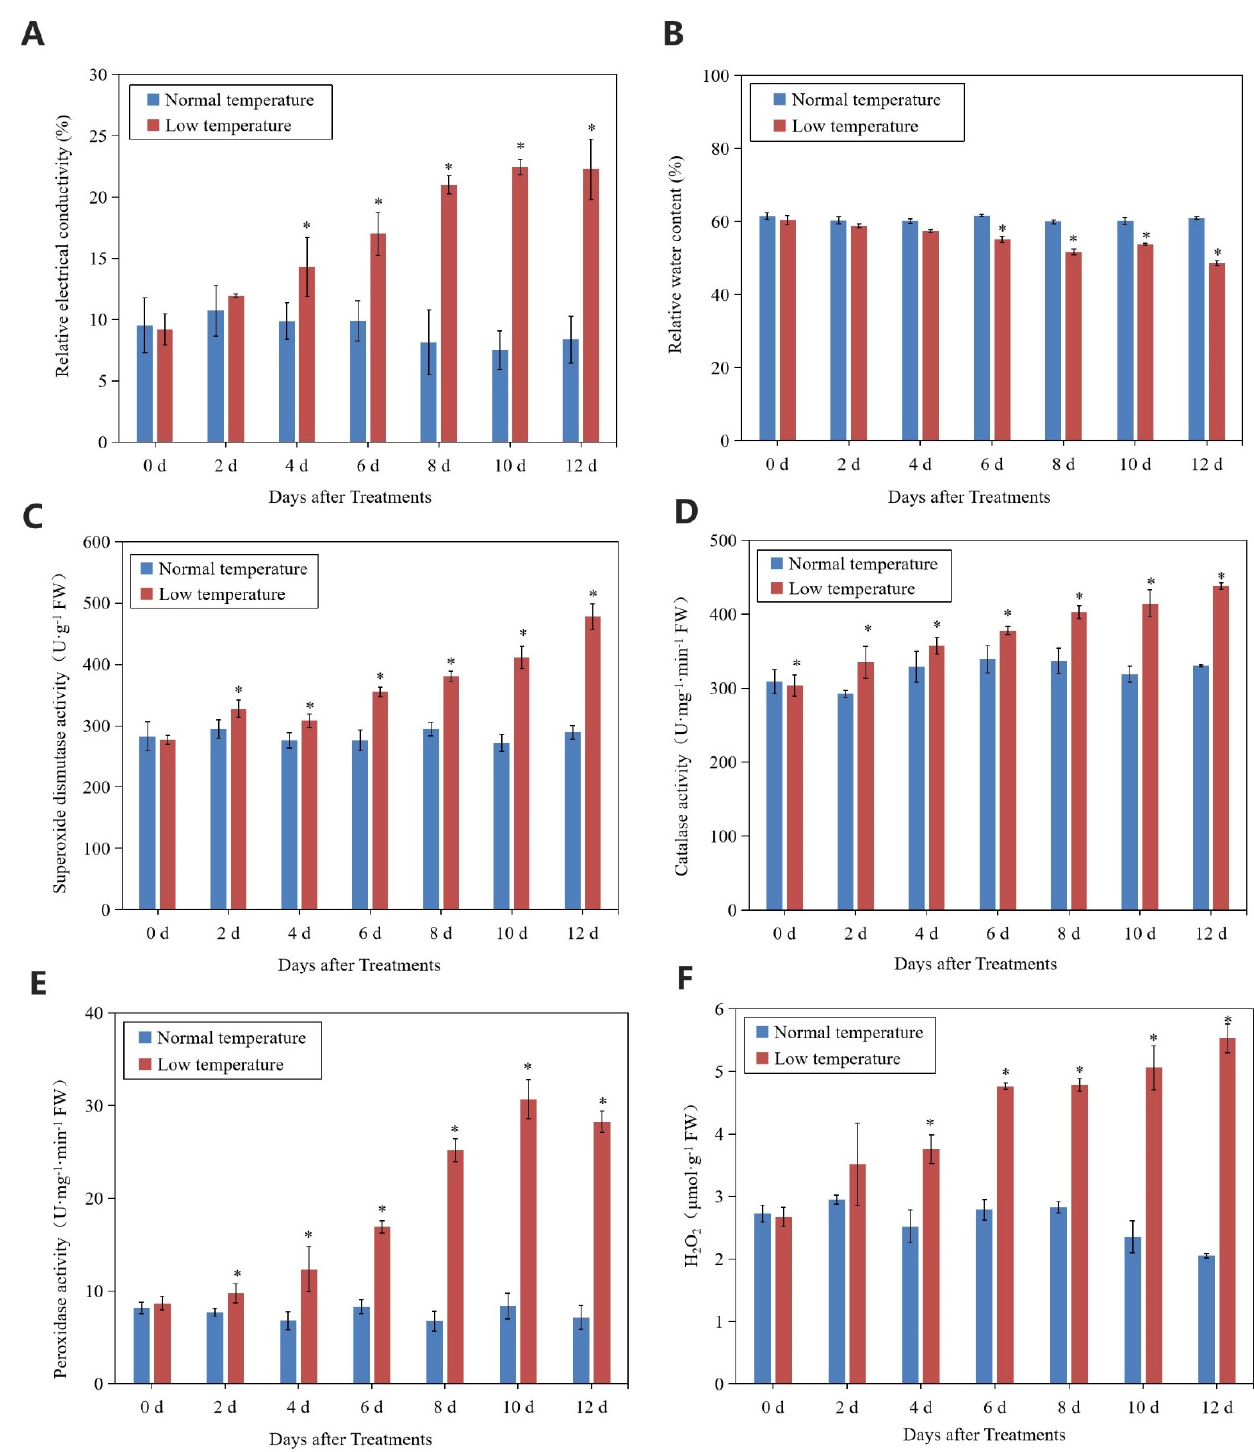
Figure 3. Changes in relative conductivity ( A ), relative water content ( B ), SOD activity ( C ), CAT activity ( D ), POD activity ( E ), and H 2 O 2 content ( F ) of leaves in ‘Huaizhi’ litchi trees under normal ‐ and low ‐ temperature conditions. ‘Huaizhi’ litchi trees were transferred to a growth chamber. Tem ‐ perature of the chamber dropped from 22 °C/17 °C (day/night temperature, 12 h day and 12 h night) to 2 °C in 4 days, and then remained at 2 °C for another 8 days. Asterisks (*) indicate significant difference between low temperature as treatment and normal temperature as control at the same time points ( p ≤ 0.05, n = 3, Student’s t ‐ test).